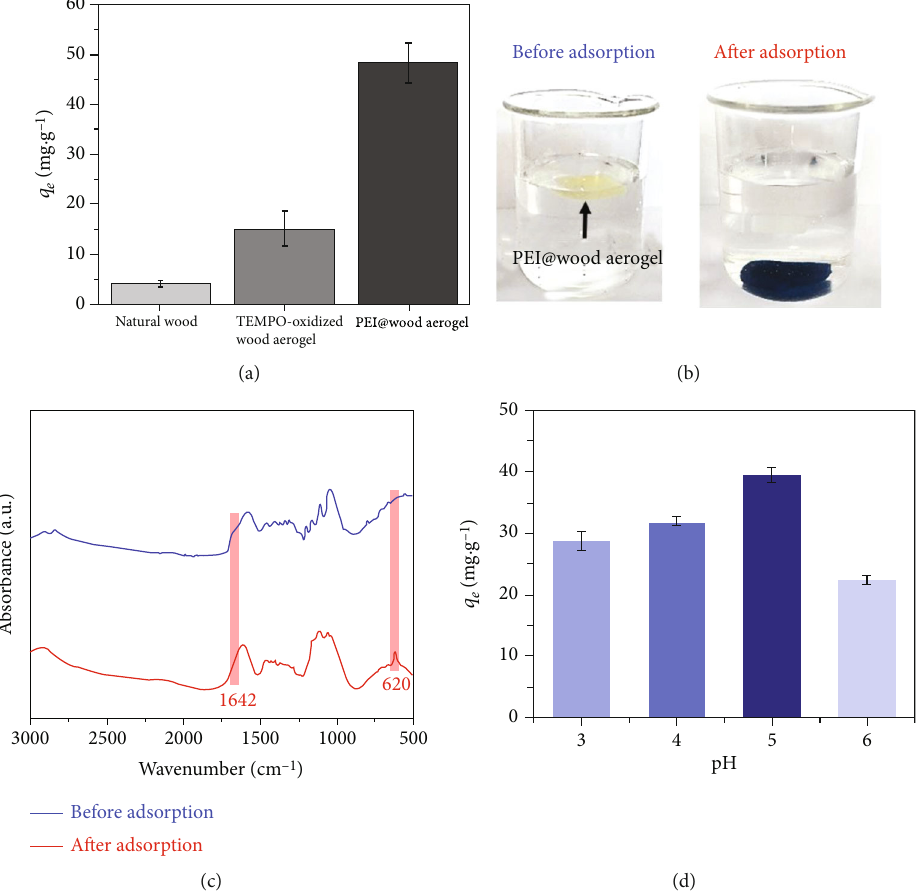
Figure 3: (a) Adsorption performance of natural wood, TEMPO-oxidized wood aerogel, and PEI@wood aerogel; (b) photographs of the PEI@wood aerogel before and after Cu(II) adsorption; (c) FT-IR spectra of the PEI@wood aerogel before and after Cu(II) adsorption; (d) e ff ect of initial pH on the Cu(II) adsorption